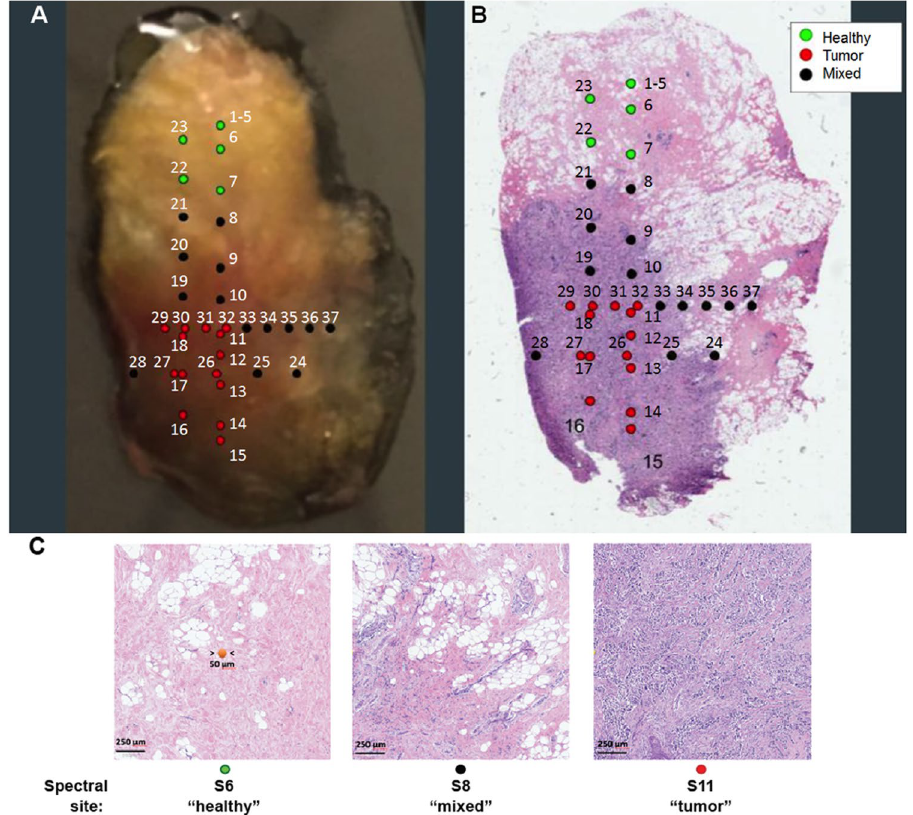
Figure 5. Representative tumor specimen and sites for collection of Raman spectra. The 785 system in microscope mode collected spectra along four transects designed to move sequentially across the visible boundaries between healthy and cancerous tissue. ( A ) Spectral collection sites along four transits pictured using a visible light image of an intact surgical specimen. Transit 1 sites are labelled 1–15; Transit 2 ran from 16 to 23; Transit 3 from 24 to 28; and Transit 4 from 29 to 37. Following data collection, the samples are fixed in formalin, embedded in paraffin, sectioned at 4 μ m, and placed on glass slides for H&E staining. Whole slide images are obtained by scanning at 20X magnification. ( B ) The corresponding H&E stained section used for standard margin analysis is shown. Target sites are color-coded according to histological classification: green for healthy, red for regions dominated by tumor, and black for a mixture of healthy and cancerous tissue (“mixed”). ( C ) H&E photomicrographs for target sites s6 (green, healthy), s8 (black, mixed), and s11 (red, tumor) acquired during first transit depicted in ( A ) and ( B ). The Raman probe samples a circular area with a diameter of approximately 50–85 μ m (in orange, a central spot representing the relative size of the laser beam). Refer to Fig. S1A for matching